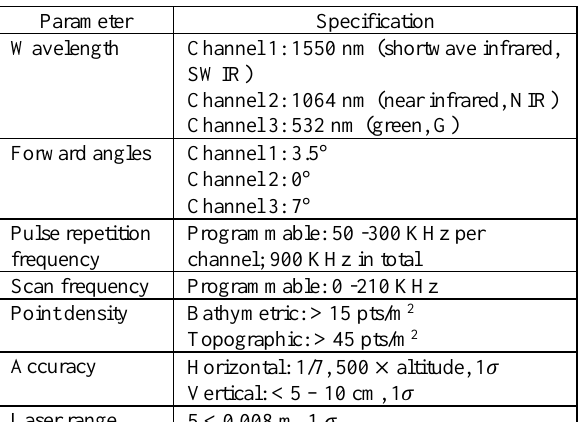
Table 1. Specifications of Optech Titan multispectral ALS system.